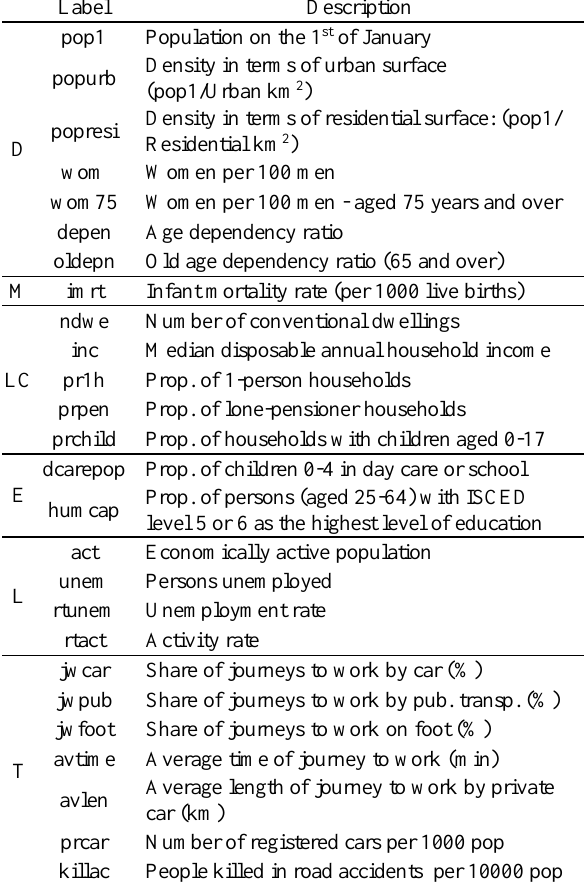
Table 2. Label and description of the final subset of socio- economic variables (URAU), grouped as: demography (D); mortality (M); living conditions (LC); education (E); labour (L); and transport (T). Further description in (Eurostat, 2016).